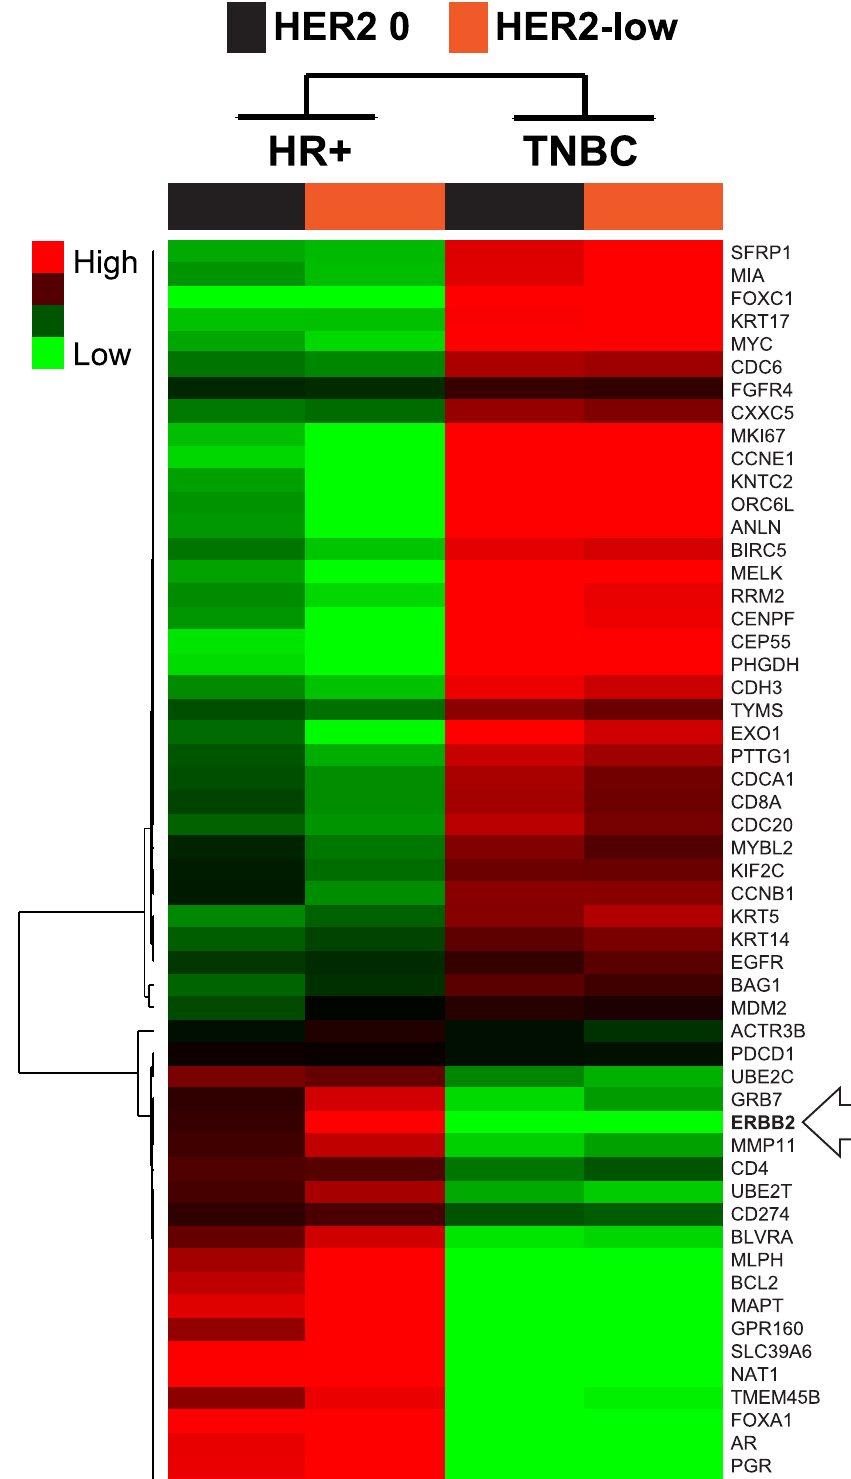
Fig. 4 Gene expression pro fi les of HER2-negative breast cancer according to HER2 expression and HR status. Supervised clustering of 55 genes across four tumor classes de fi ned according to HER2 IHC expression and HR status. All samples and gene expression data in each category have been combined into a single group. For each gene in a group, we calculated the standardized mean difference between the gene ’ s expression in that class vs. its overall mean expression in the dataset using a 4-class Signi fi cance Analyses of Microarrays. The red color represents relative high gene score, green represents relative low gene score, and black represents median gene score. HR-positive hormone receptor positive, TNBC triple-negative breast cancer.